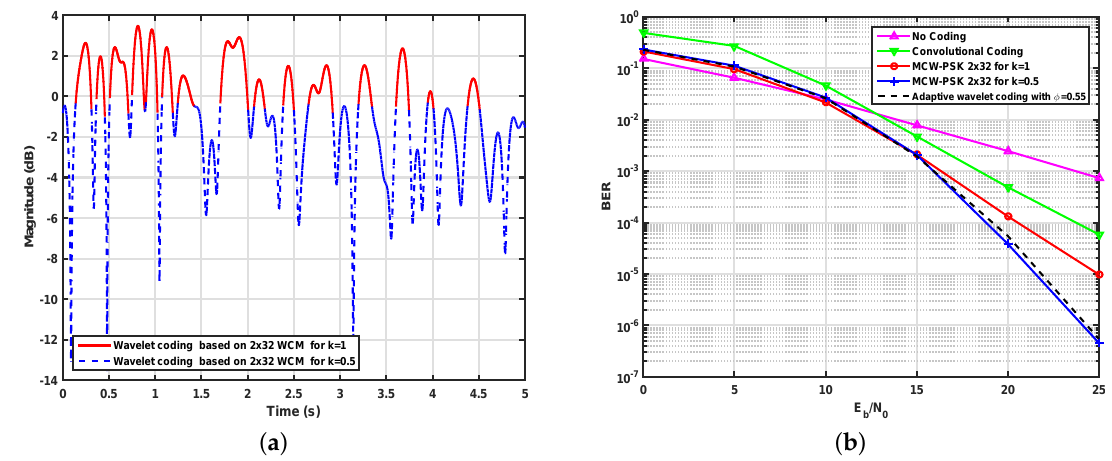
Figure 7. ( a ) Illustration of the behavior of the implemented wavelet adaptive encoder; ( b ) system performance with adaptive wavelet